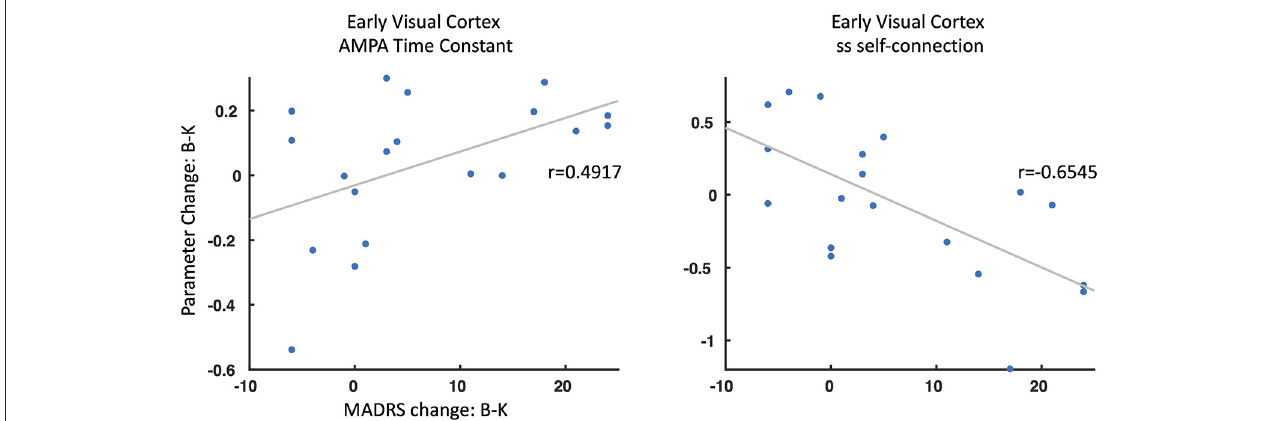
FIGURE 4 | Parameter change and antidepressant response. Two parameters showed a significant association between change from baseline (B) to ketamine (K) sessions and associated changes in Montgomery-Asberg Depression Rating Scale (MADRS) scores (B–K). ss, spiny stellate cells; AMPA, α -amino-3-hydroxy-5-methyl-4-isoxazolepropionic